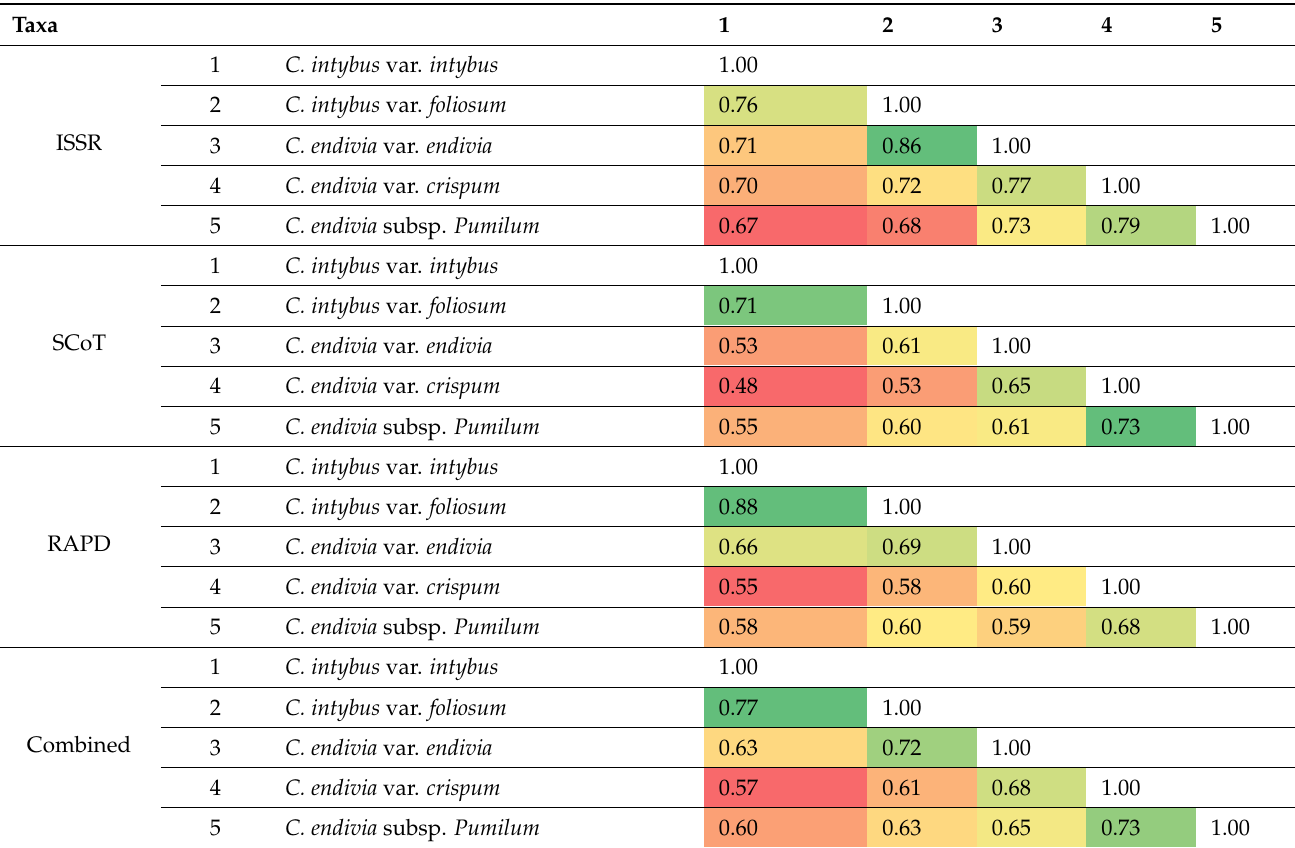
Table 4. Proximity matrix using Jaccard coefficient among the taxa of Cichorium